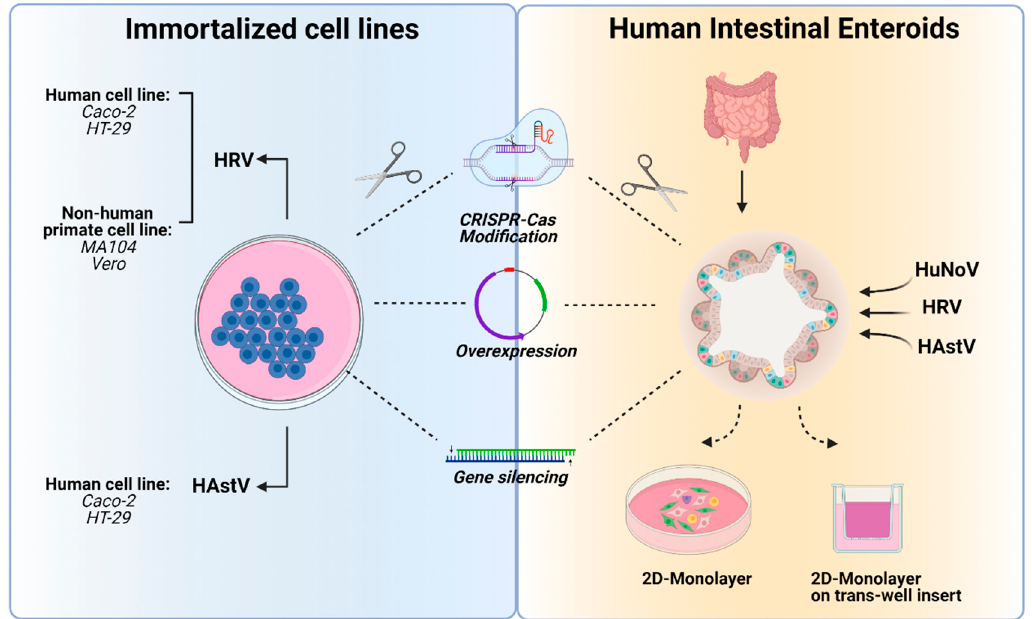
Figure 1. In vitro methods commonly used for the study of human noroviruses (HuNoVs), rotaviruses (HRVs) and astroviruses (HAstVs). Immortalized cell lines and human intestinal enteroids have been used for the study of human enteric viruses. Modifications to cells either to facilitate infections and/or interrogate the role of host genes during infection can be performed using methods including CRISPR-Cas9-based editing, gene overexpression or silencing. Created with BioRender.com (accessed on 21 January